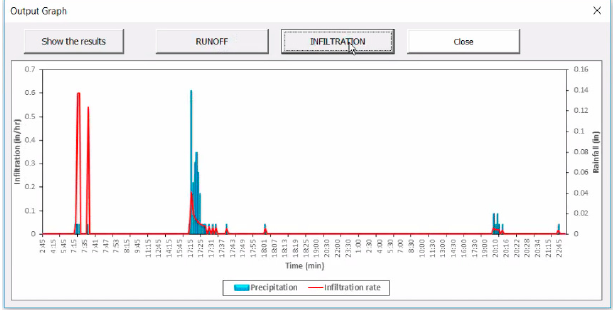
Figure A9. Displaying infiltration rate.